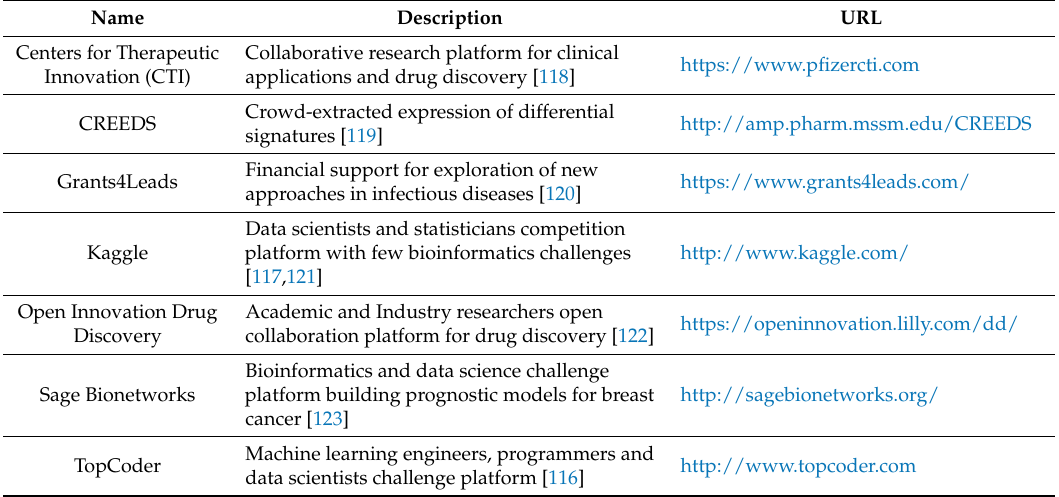
Table 3. Open innovation research